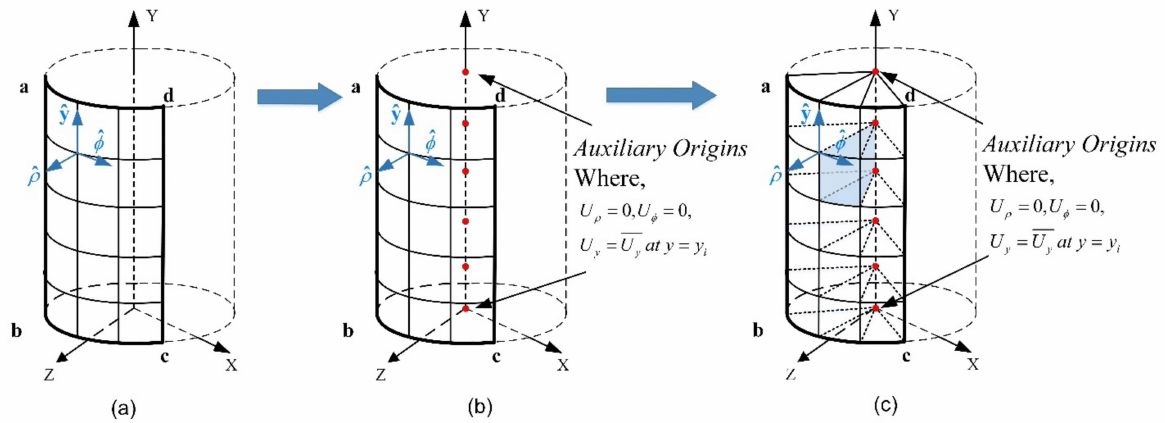
Figure 3. Schematic illustration of 3D study objects: ( a ) the initial geometry of the specimen; ( b ) the assumed auxiliary origins along the axis of the specimen; ( c ) connecting boundary coordinates with added auxiliary origins to form the 3D study